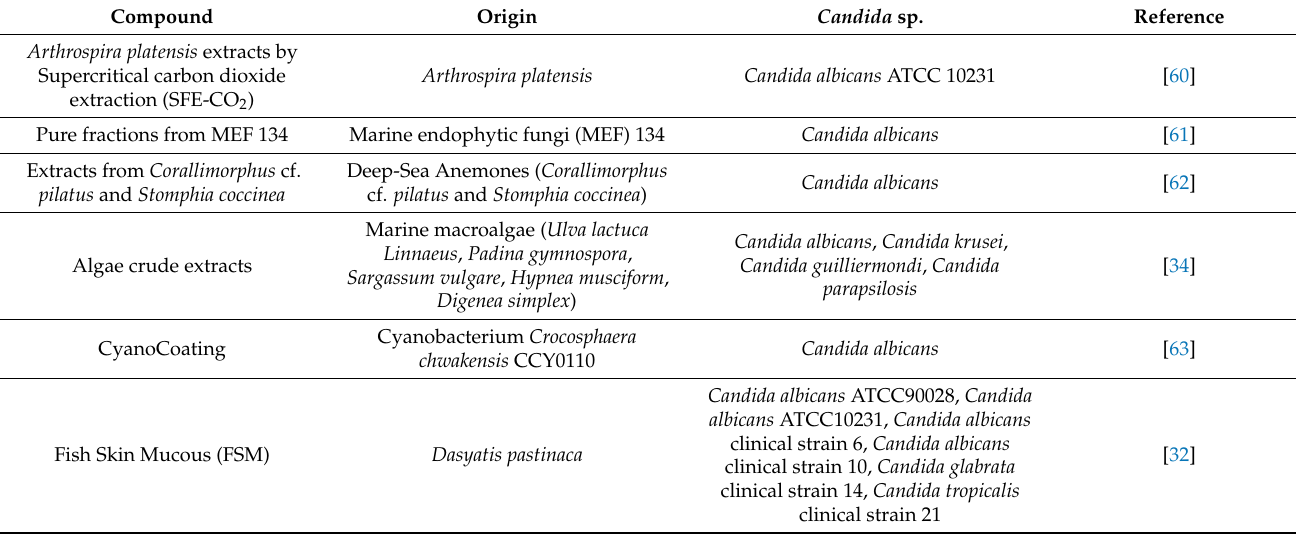
Table 3. Antifungal activity of marine extracts and sub-products.